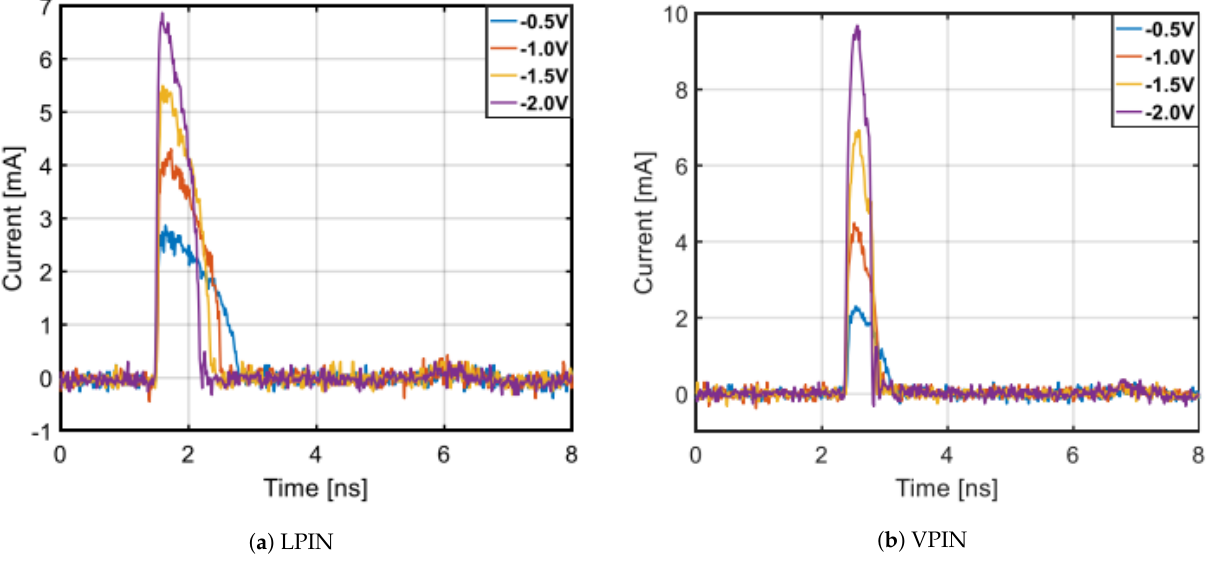
Figure 8. Captured transients from ( a ) LPIN and ( b ) VPIN photodiodes (after